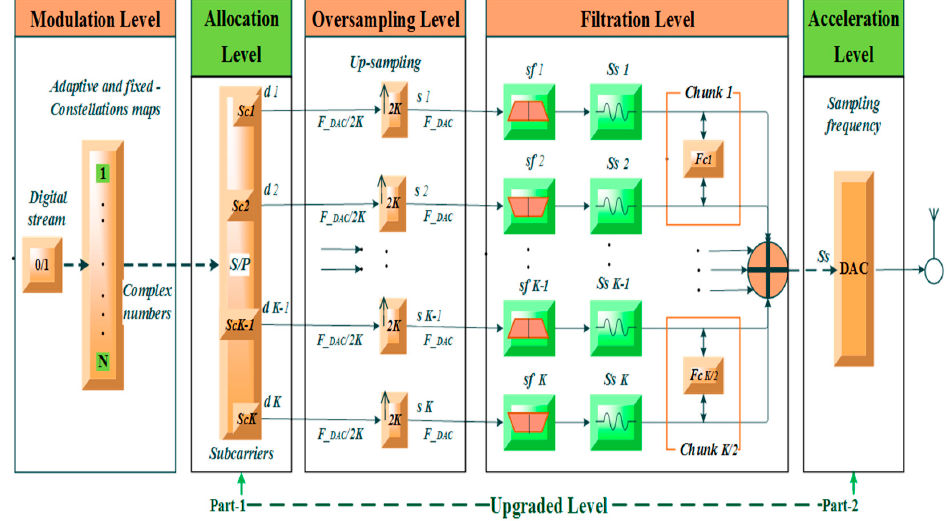
Figure 1. Transmitter design of the orthogonal generalized frequency division multiplexing (OGFDM) including the two key parts of the upgraded level.